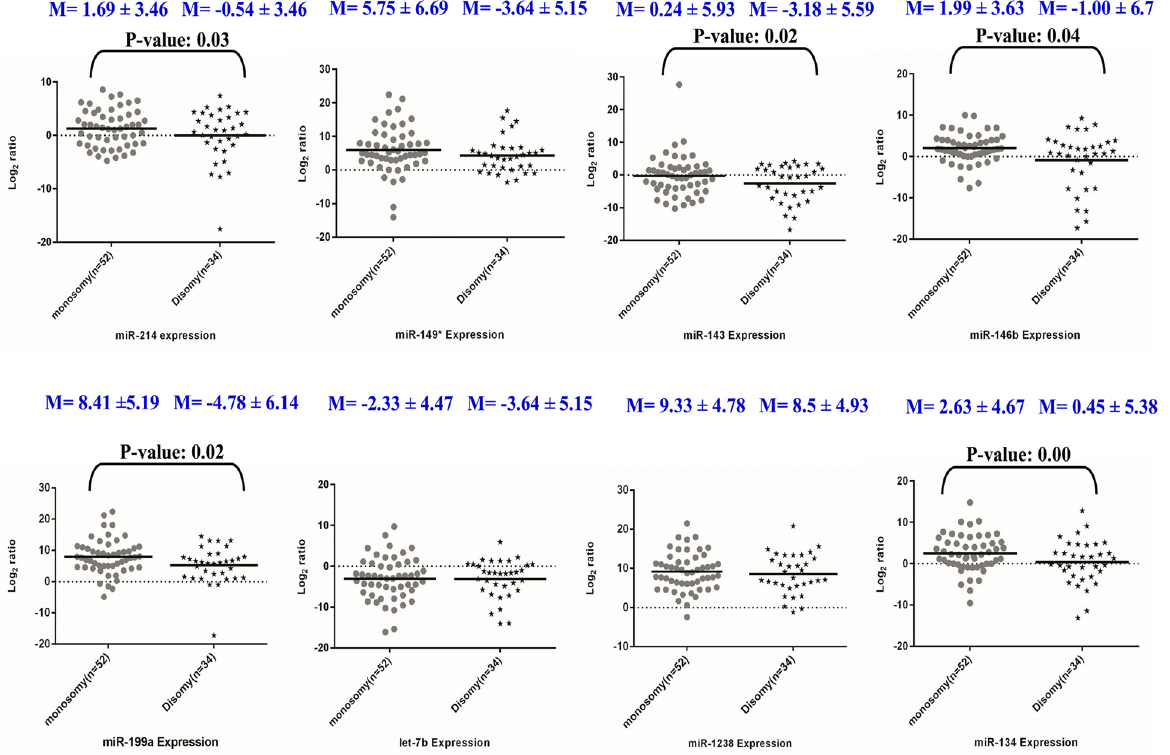
Fig 3. Graphical representation of the miRNA expression (fold change in log 2 ratio) in M3 / D3 UMs derived using Graph pad Prism. The dotted line represents the mean fold change of miRNA expressions while "M" denotes the mean fold change of the respective miRNA expression in UM groups.